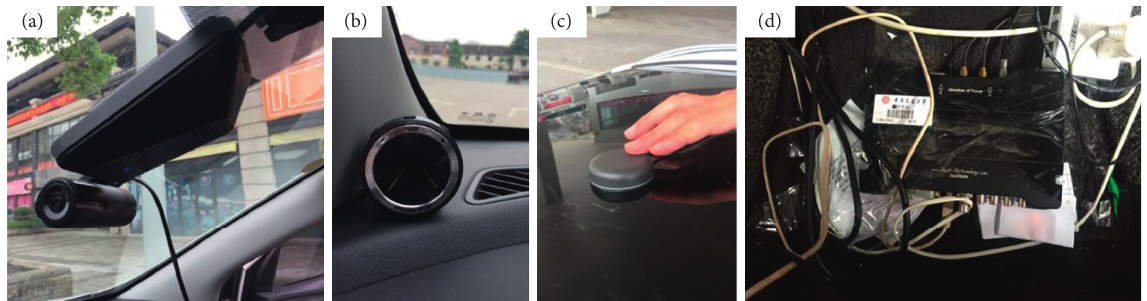
Figure 3: On-board apparatus used in driving tests. (a) Mobileye 630; (b) tachograph; (c) antenna of SPEEDBOX; (d) controller of SPEEDBOX.